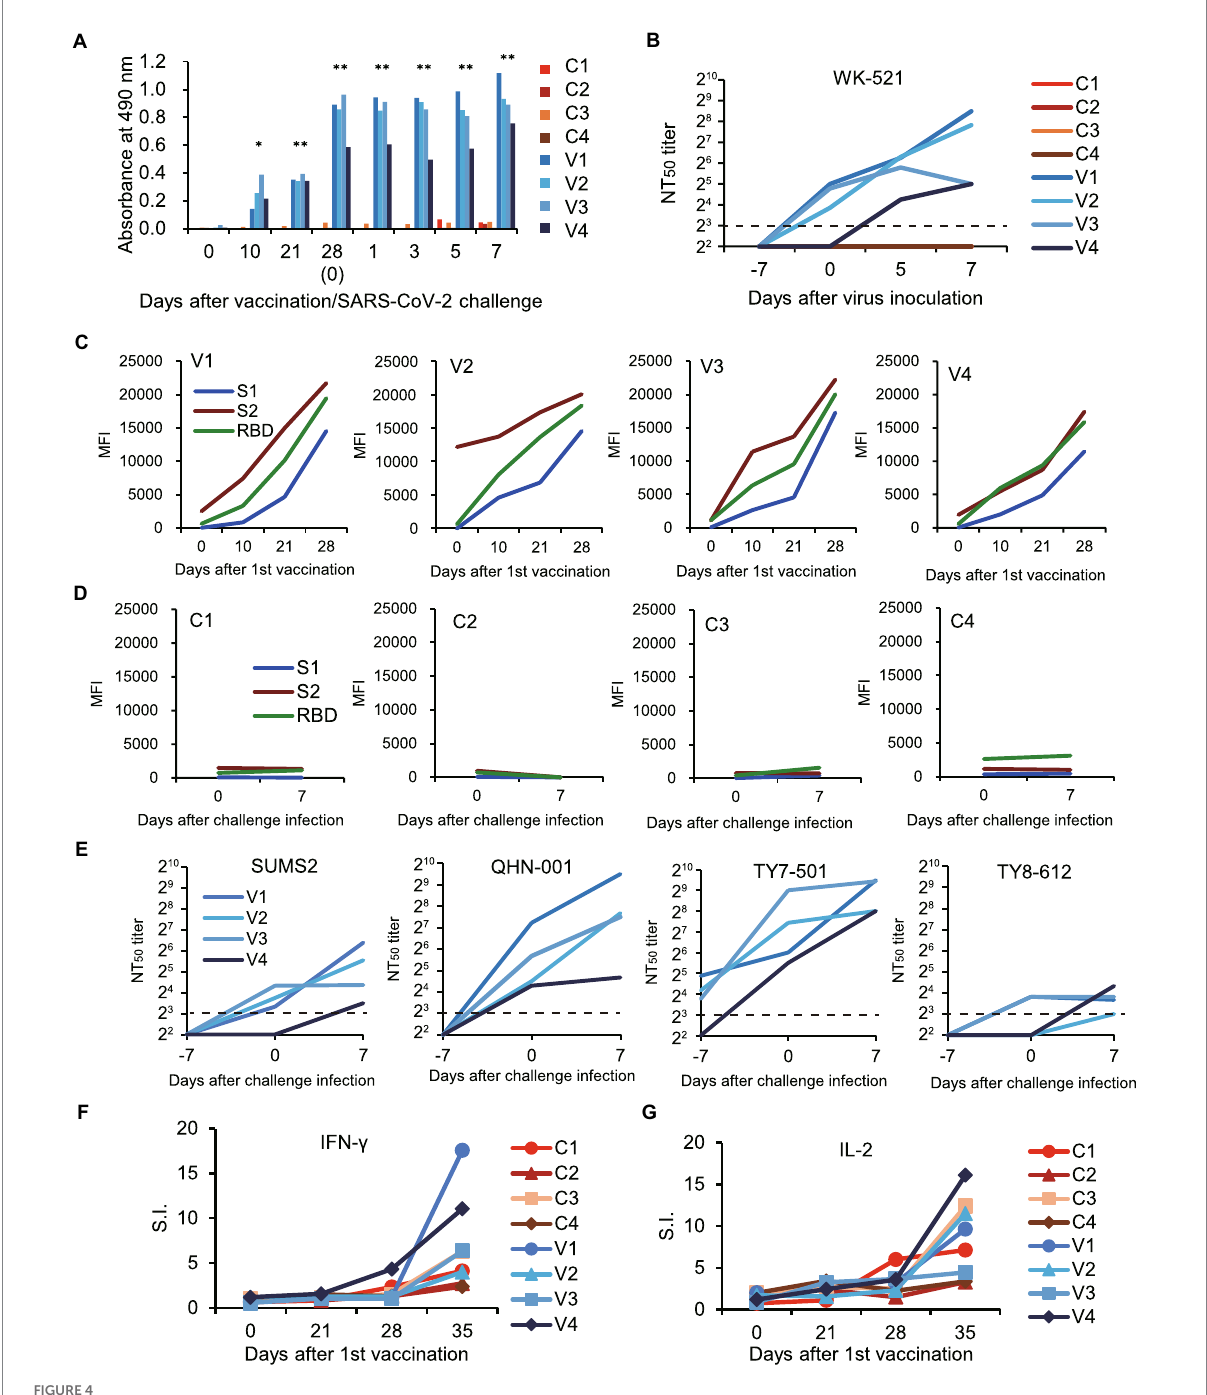
FIGURE 4 Immune responses in macaques vaccinated with rDIs-S. The macaques were immunized intradermally with DIs (C1–C4) or rDIs-S (V1–V4). One week after the second vaccination, SARS-CoV-2 strain WK-521 was inoculated at Day 0. (A) The levels of IgG specific for SARS-CoV-2 S protein in the plasma of macaques immunized with DIs (C1–C4) and macaques immunized with rDIs-S (V1–V4) were analyzed using ELISA. Plasma was collected after the first vaccination (Days 0–28) and after challenge infection (Days 1–7). Significant differences were calculated by a two-tailed unpaired Student’s t -test (* p < 0.05, ** p < 0.01). (B) 50% neutralization titers (NT 50 ) of plasma against strain WK-521. Plasma was collected from macaques on the indicated days after the first vaccination. Day 7: the day of the second vaccination and 7 days before challenge infection. Day 0: the day of challenge infection. Day 0 samples were collected before infection. Days 5 and 7: 5 and 7 days (respectively) after challenge infection. (C,D) Plasma IgG specific for SARS-CoV-2 S1, S2, and receptor-binding domain (RBD). MFI, mean fluorescence intensity. (E) Levels of neutralizing antibodies against variants of SARS-CoV-2. NT 50 of plasma against variant strains with amino acid changes in the S protein were measured. (E,F) The numbers of IFN- γ -producing cells (F) and IL-2-producing cells (G) specific for SARS-CoV-2 S protein peptides were examined by the ELISpot assay. Stimulation indices (S.I.) were calculated as follows: S.I. = number of spots in the culture of cells with peptides/number of spots in the culture of cells without